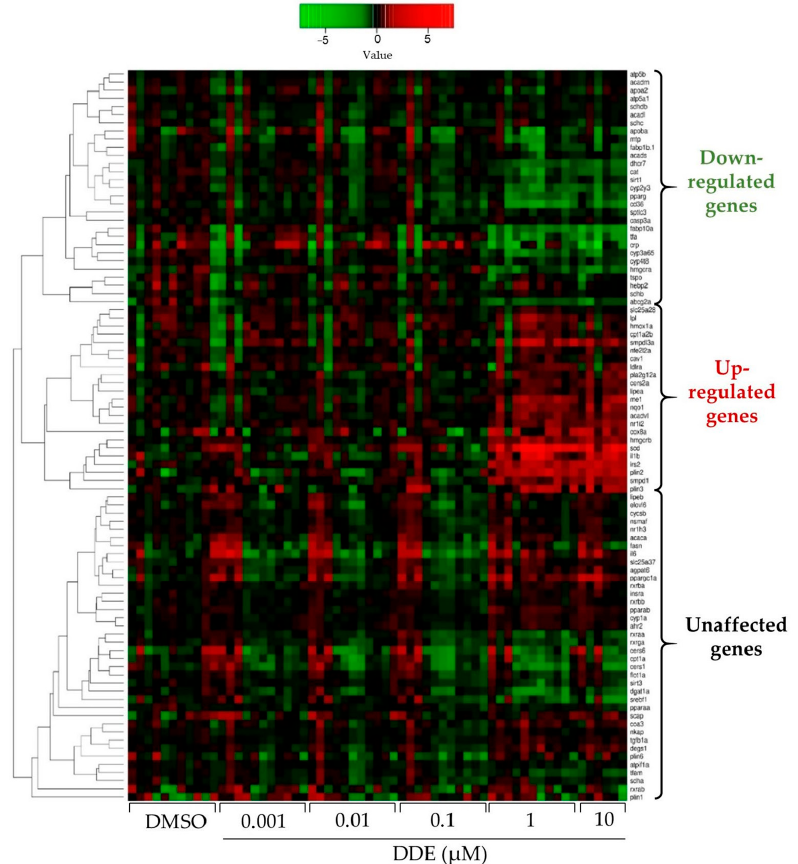
Figure 5. Heatmap showing the impact of DDE on mRNA expression of different genes related to metabolic pathways. mRNA expression was evaluated by RT-qPCR gene expression analysis by using the microfluidic Fluidigm-Biomark technology. Zebrafish larvae were exposed to DDE (from 1 nM to 10 µ M) during 48 h, from 3 to 5 dpf. mRNA expressions of 90 genes related to nuclear receptors, lipid homeostasis, liver metabolism, inflammation and oxidative stress were analysed; results are shown as a heatmap (each raw represents an independent mRNA sample extracted from a pool of zebrafish larvae). Data are expressed as mean expressions relative to mRNA levels measured in DMSO control larvae, set at 0 (log 2 fold change) ( n ≥